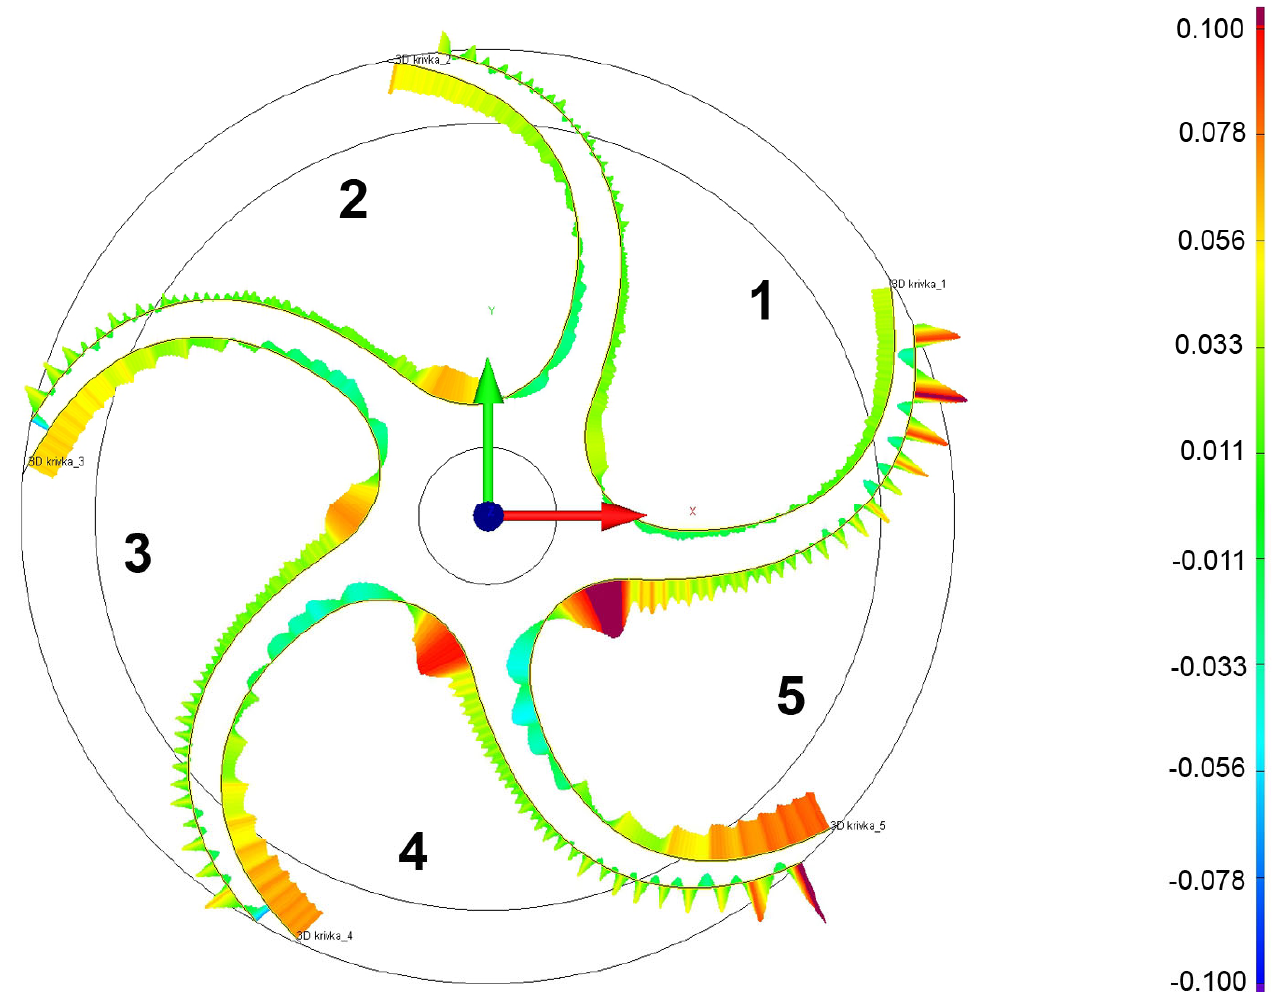
Figure 5. Deviations on the sidewalls of the sample made with the CAM system.